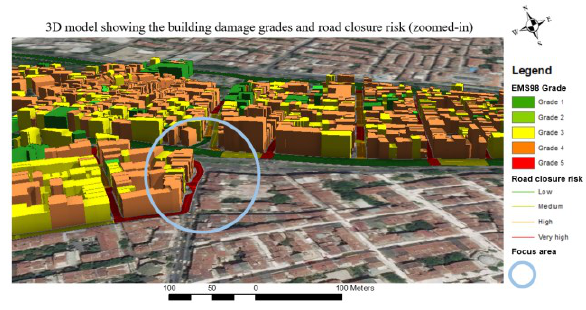
Figure 13 . 3D model zoomed-in. Web scene: https://bit.ly/3KJiv7c . Source: de Vries,